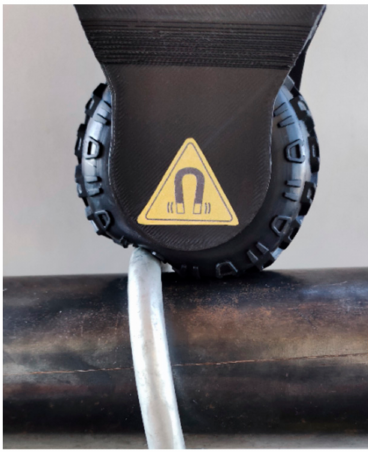
Figure 7. Special design of flexible rubber tire allows to overcome obstacles without separation from the ferromagnetic surface. Copyrighted by